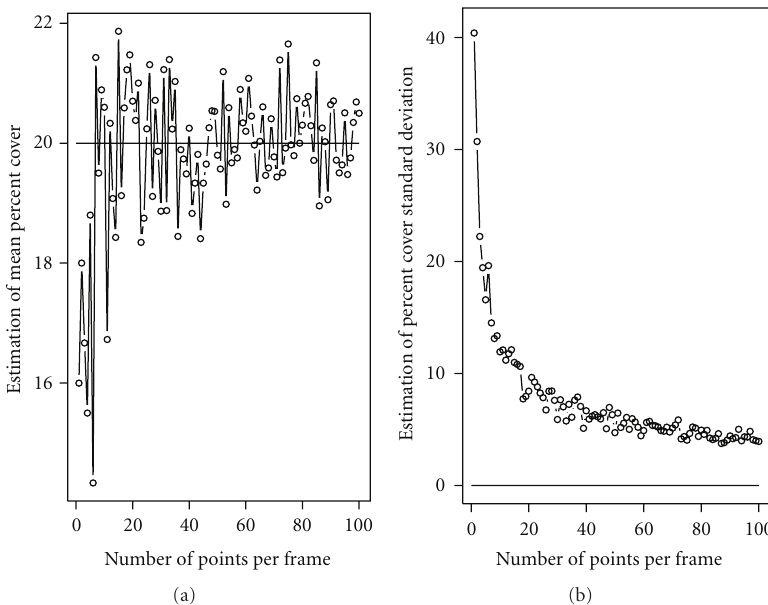
Figure 2: Performance of point count estimation of a transect mean percent cover ((a): μ = 20%) and its standard deviation ((b): σ = 0) using di ff erent numbers of points per frame. The horizontal line represents the value of the simulated parameter.